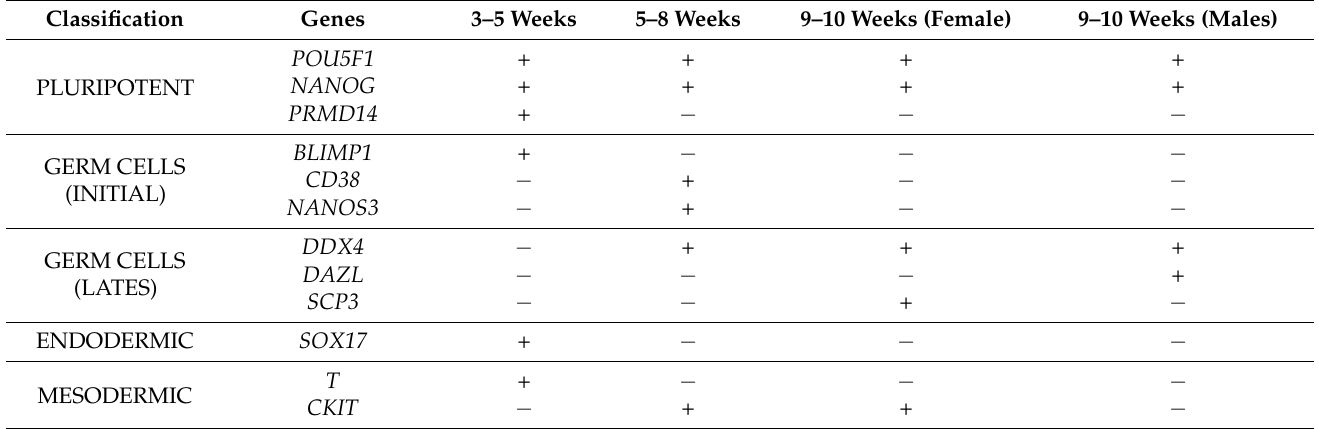
Table 1. A summary of relevant genes for the specification of human PGCs.